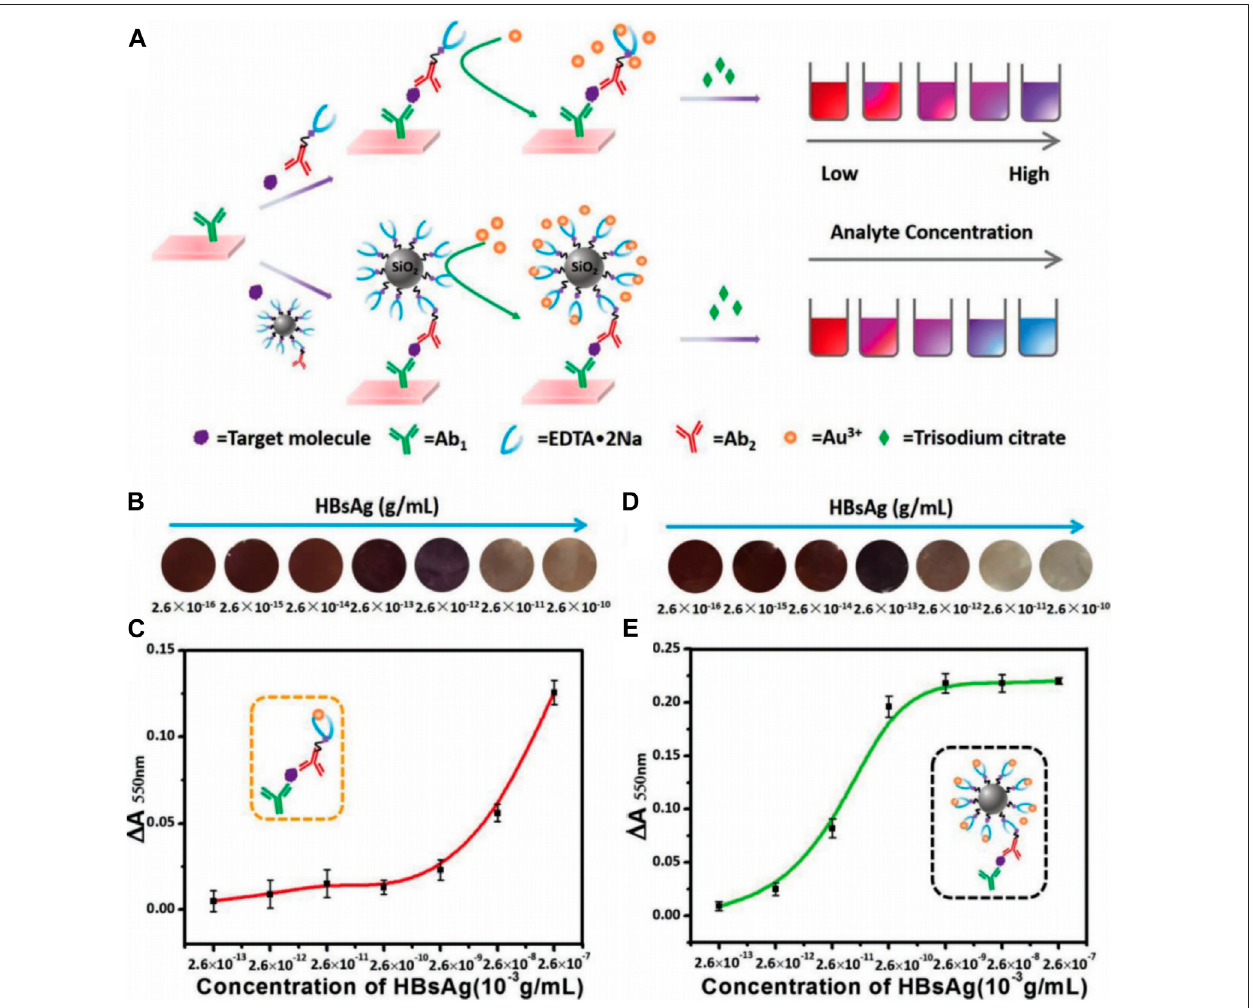
FIGURE 1 | (A) Schematic illustration of Scadge-Diag and SiO 2 NPs-ampli fi ed Scadge-Diag. (B,D) Practical detection of HBsAg by naked-eye visualization and (C,E) plotting absorbance values of AuNPs collected at 550 nm versus varying concentrations of HBsAg based on (B,C) Scadge-Diag and (D,E) SiO 2 NPs-ampli fi ed Scadge-Diag, respectively. Reprinted with permission from Zhao et al. (2018). Copyright (2018) John Wiley and Sons.